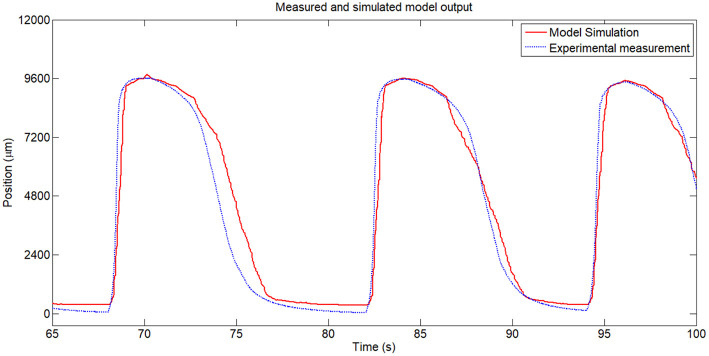
Zoomed area from Figure 6.